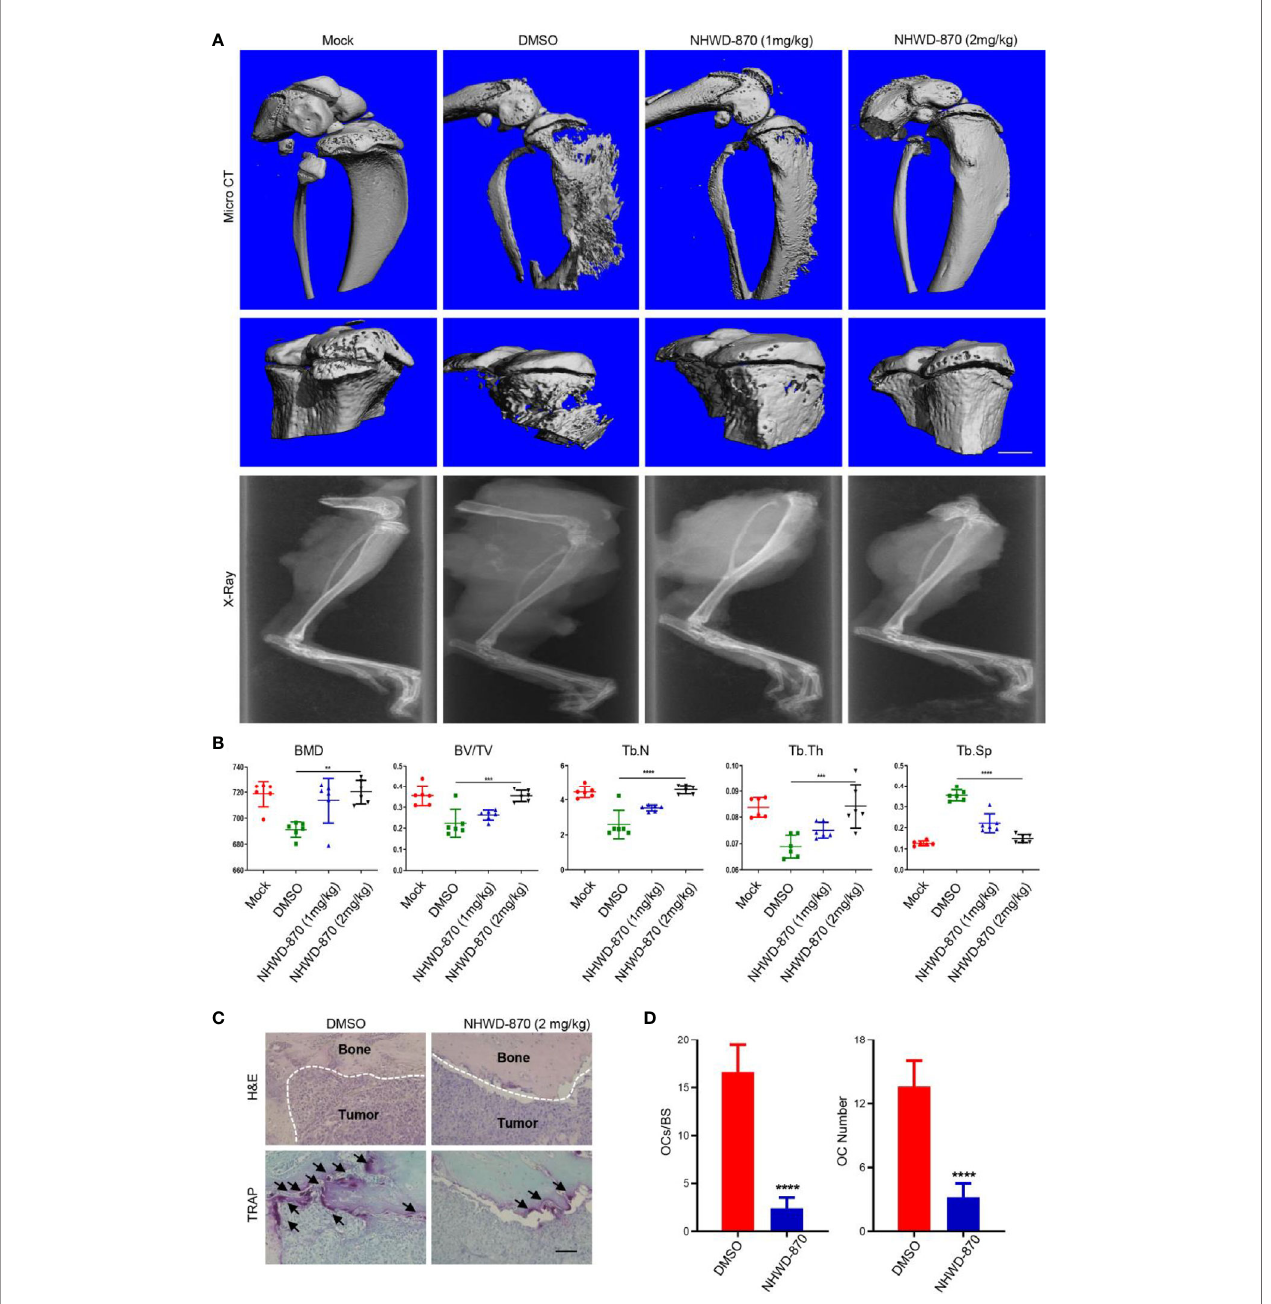
FIGURE 6 | NHWD-870 inhibits tumor-induced osteolysis by inhibiting the differentiation and maturation of osteoclast precursor. (A) The effect of NHWD-870 on inhibiting tumor-induced osteolysis in vivo in each group was detected by micro-CT. Scale bar = 1 mm. (B) Relative parameters of the bone microstructure in each group. (**P < 0.01; and ***P < 0.001, and ****P < 0.0001). (C) The number and distribution of osteoclasts at the tumor-to-normal bone boundary was detected by TRAP. Scale bar = 100 m m. (D) A signi fi cant decrease in the number and distribution of osteoclasts demonstrated that NHWD-870 inhibited the differentiation and maturation of osteoclasts, preventing tumor-induced osteolysis. (****P <